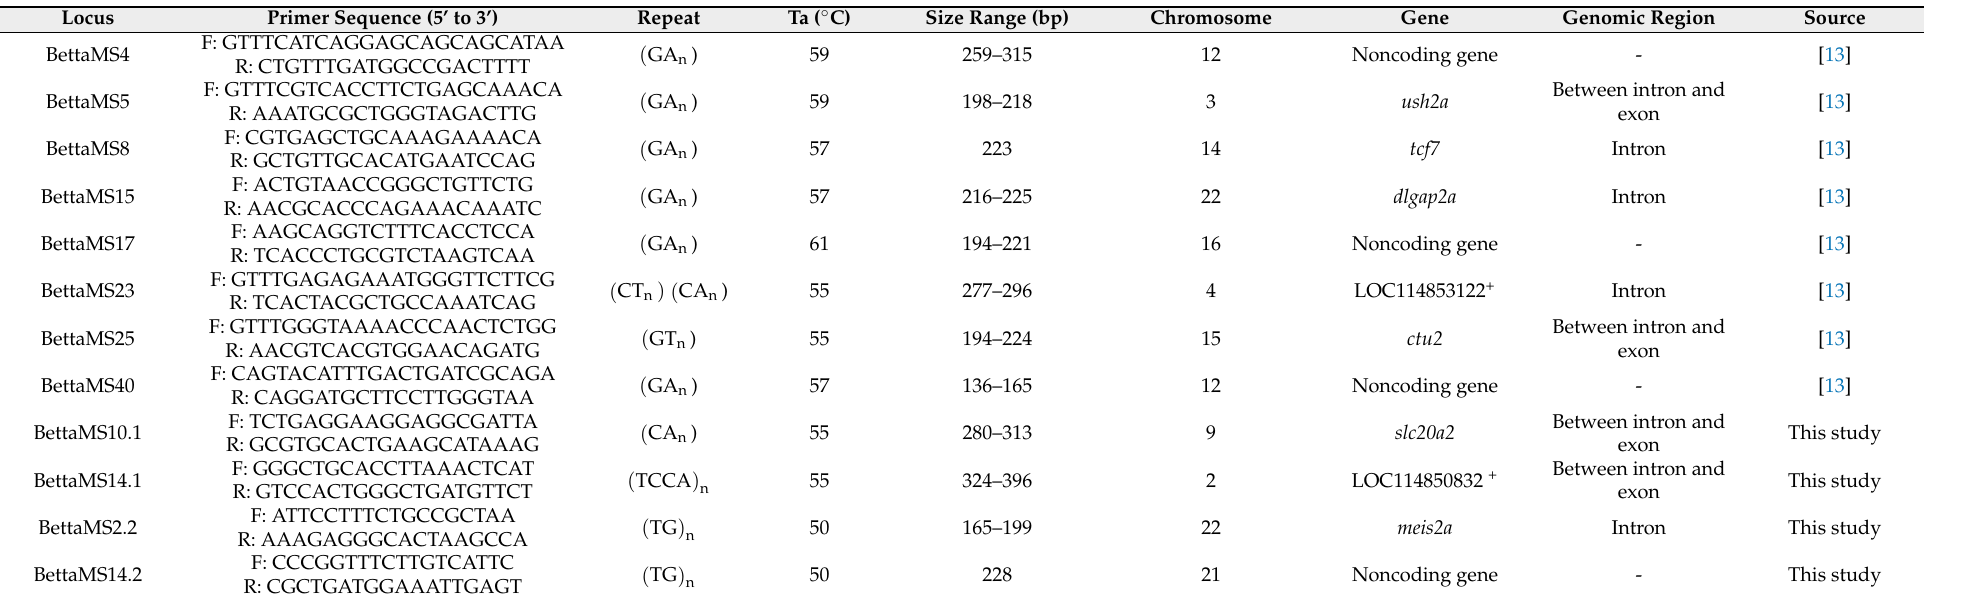
Table 2. Characteristics of microsatellite markers investigated in this